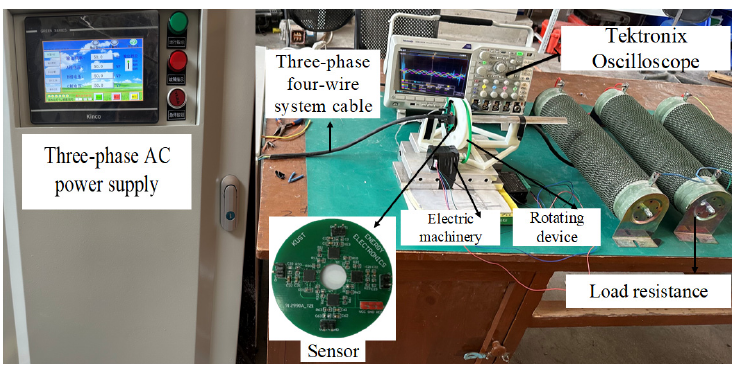
Figure 13. Physical drawing of the three-phase four-wire current measurement experimental sys- tem.